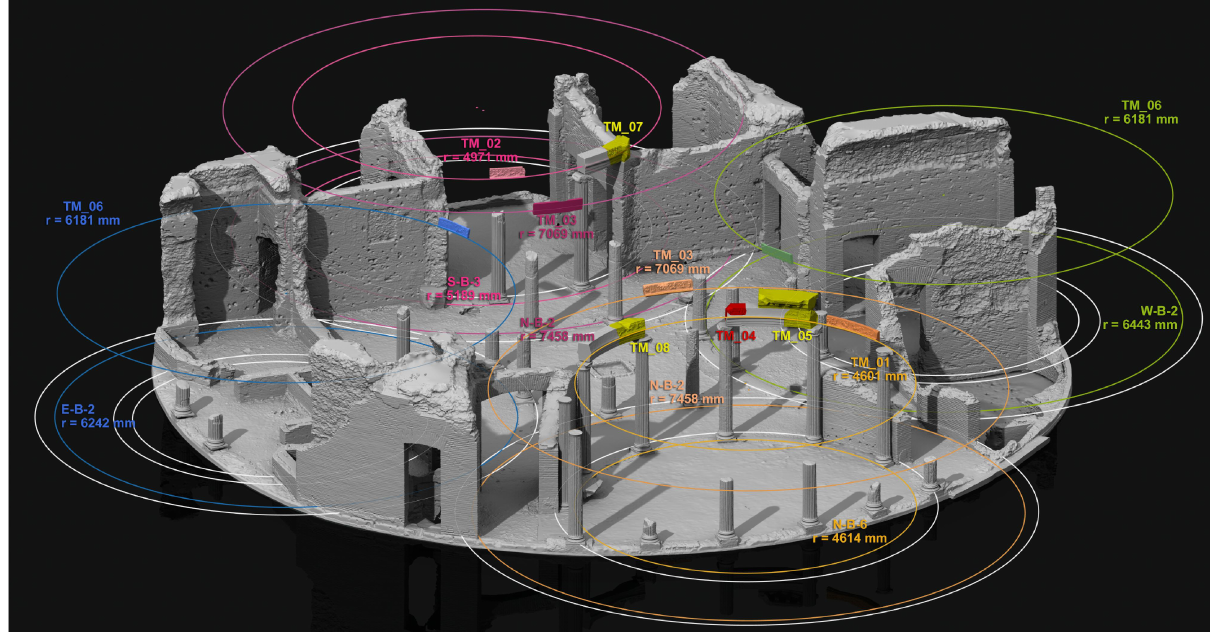
Figure 14. Hypothesis of the virtual anastylosis of some